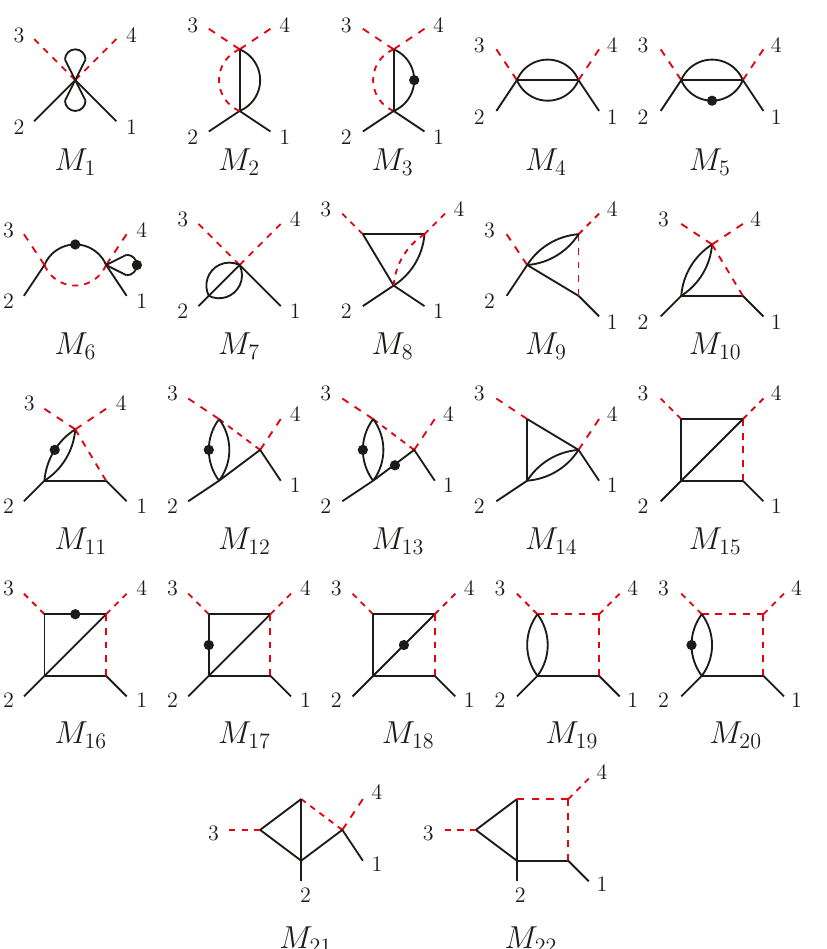
Figure 8. Master integral basis for the pentatriangle topology shown in figure 7. Black-solid lines represent massive particles, red-dashed lines represent massless